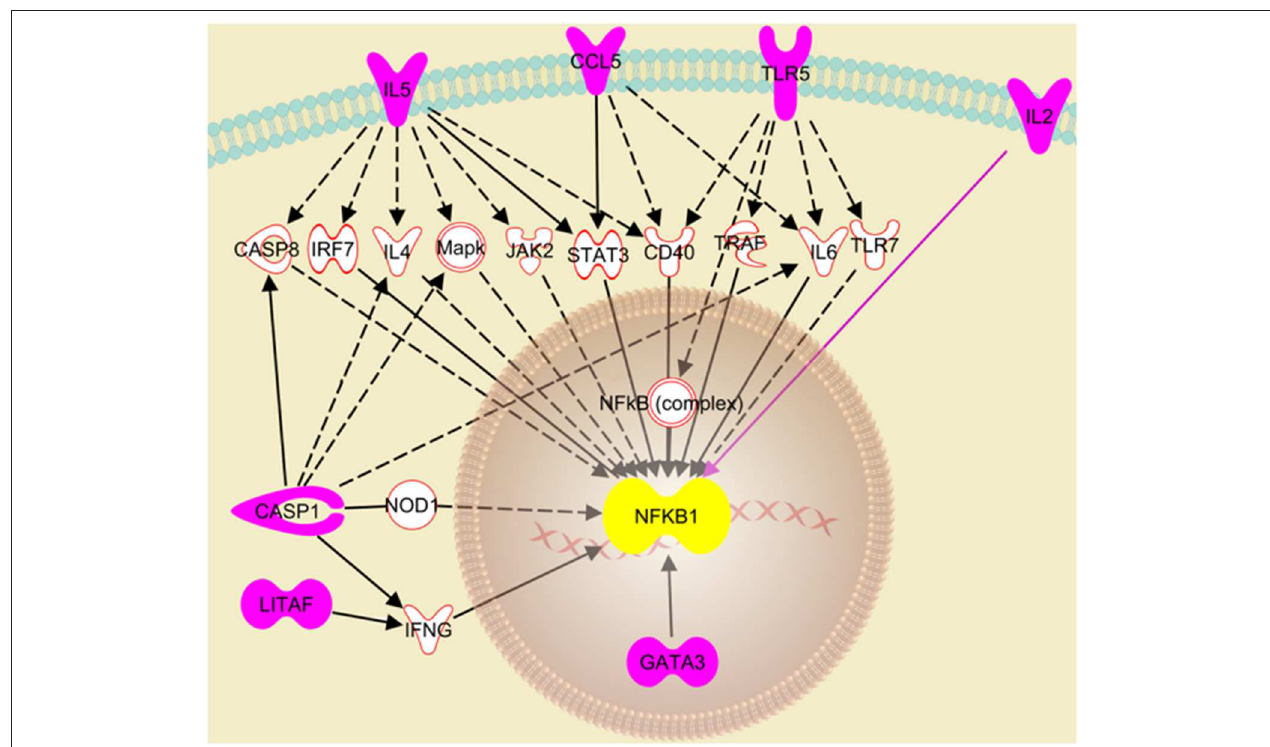
FIGURE 7 | Putative pathway showing regulatory relationships of key genes to NF κ B activation transcriptionally regulated by NLRC5. Ingenuity Pathway Analysis revealed seven genes (pink fill) which were significantly upregulated after NLRC5 KD macrophages were infected with LPAIV H5N2 and are indicative of activation of the NF κ B gene response. The dashed lines represent an indirect relationship, and a solid black or pink line represents a direct relationship. The solid white molecules are the intermediate factors which take part in activation of NF κ B and were also observed to be